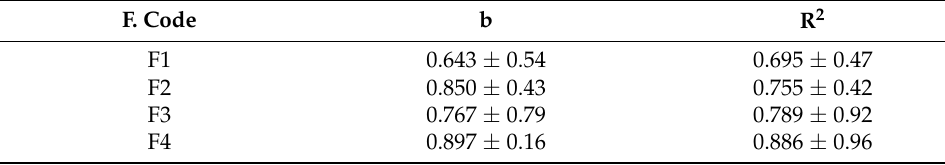
Table 4. The release kinetic mechanism using the Weibull